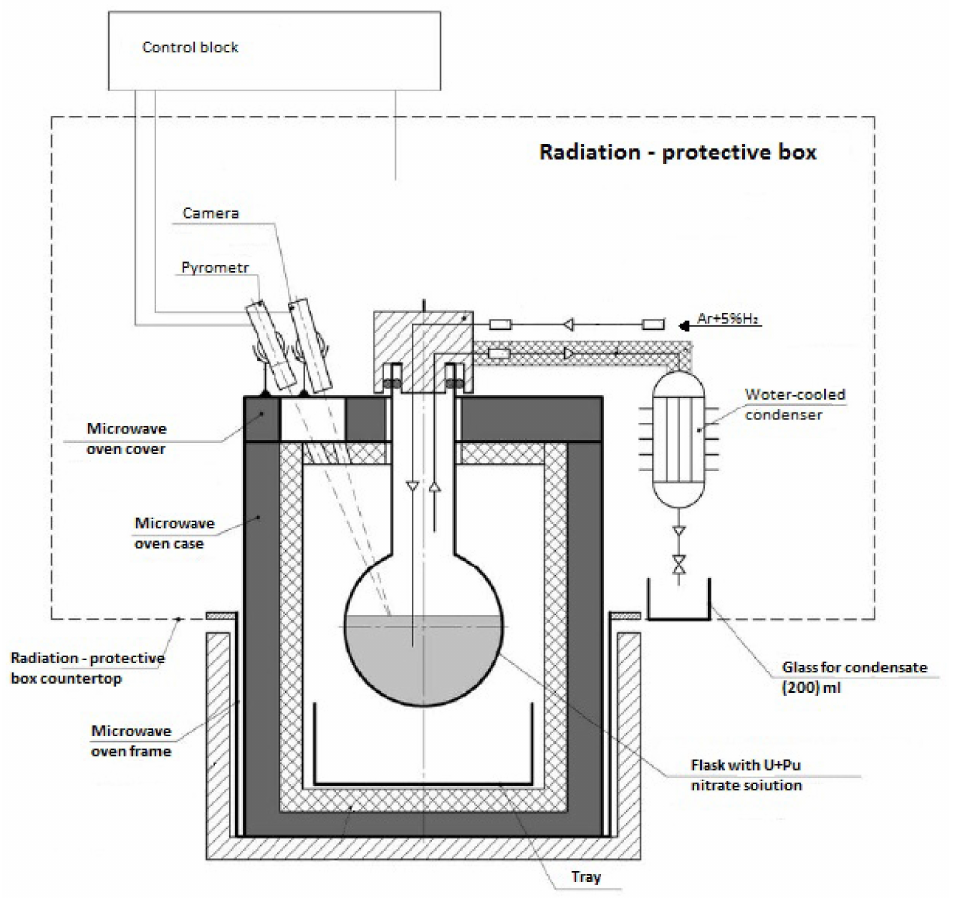
Figure 1. Scheme of the laboratory microwave denitration unit in the glove